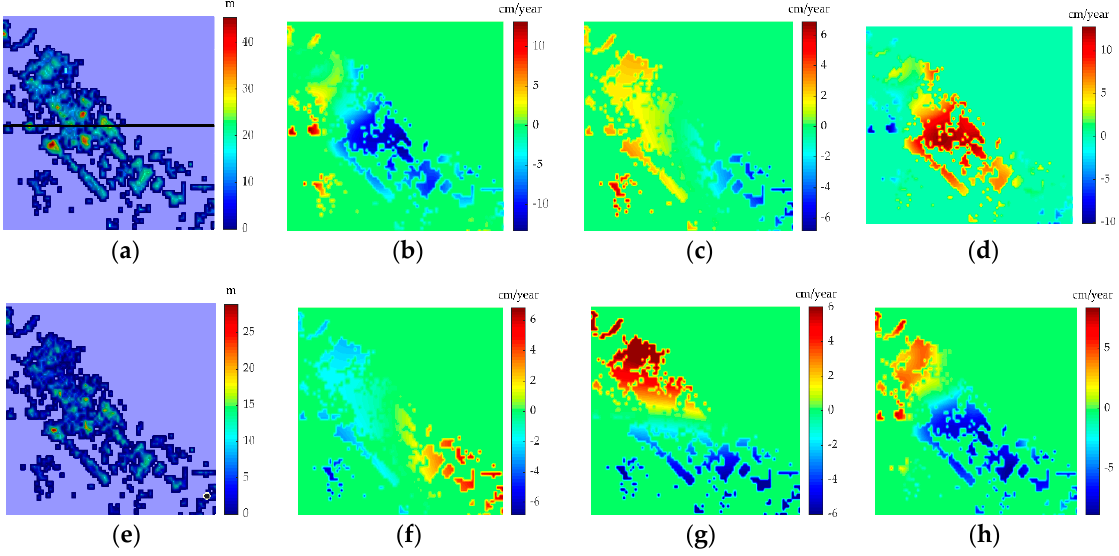
Figure 12. The simulation of elevation and deformation maps. ( a – d ) are the simulated elevation of the dominant scatterer and its simulated deformation velocities along the slant range, azimuth, and elevation directions, respectively. ( e – h ) correspond to the secondary scatterer.